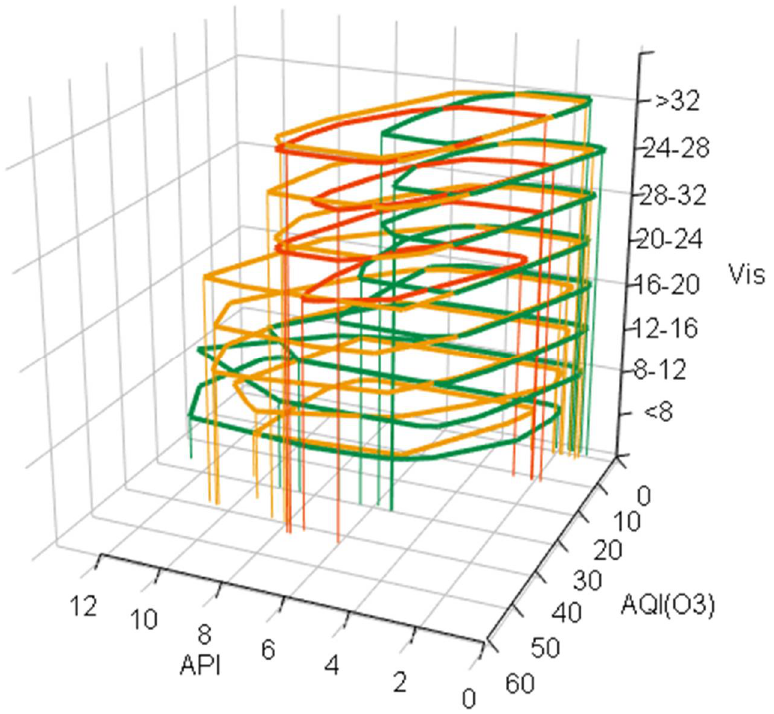
Figure A16. Effect of visibility-dependent air O 3 concentration on the air pollution index for the spring, summer and winter rain-free periods.